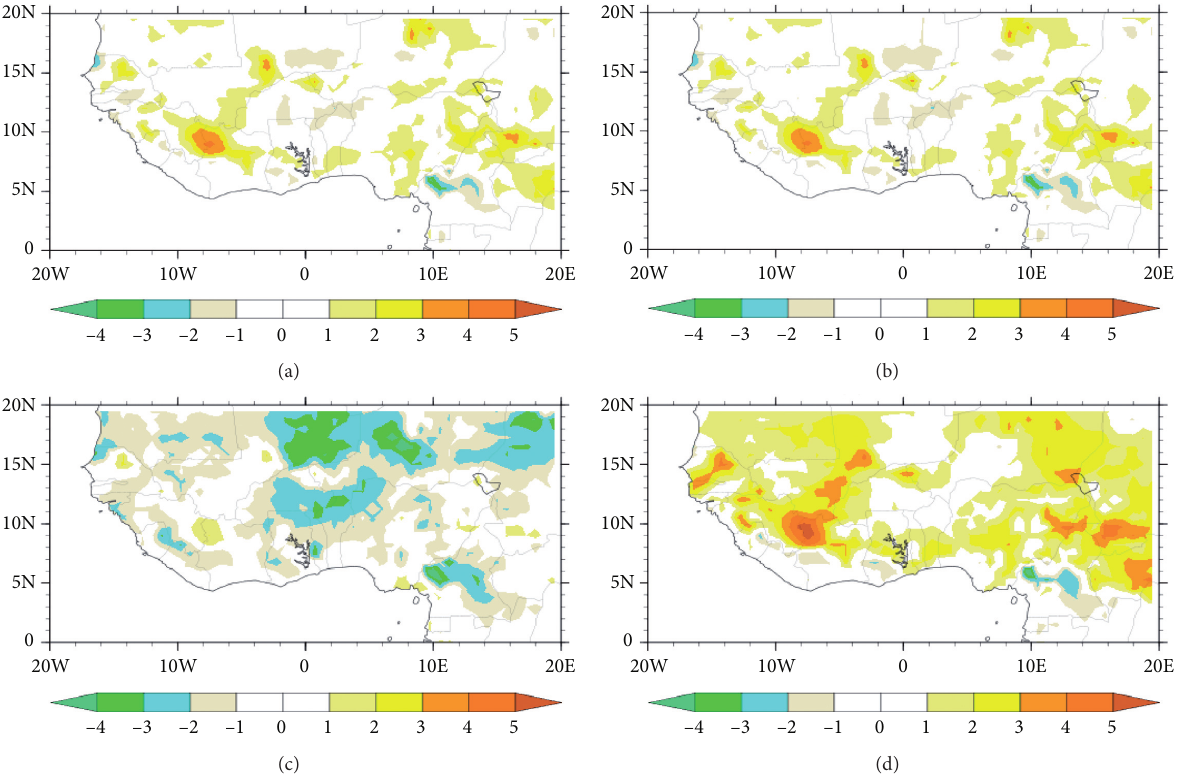
Figure 5: Spatial bias of average temperature ( ° C) for December 16 th , 2011, to February 28 th , 2012. (a) Noah-MP groundwater option-ERA. (b) Noah-MP-ERA. (c) Noah-ERA. (d)